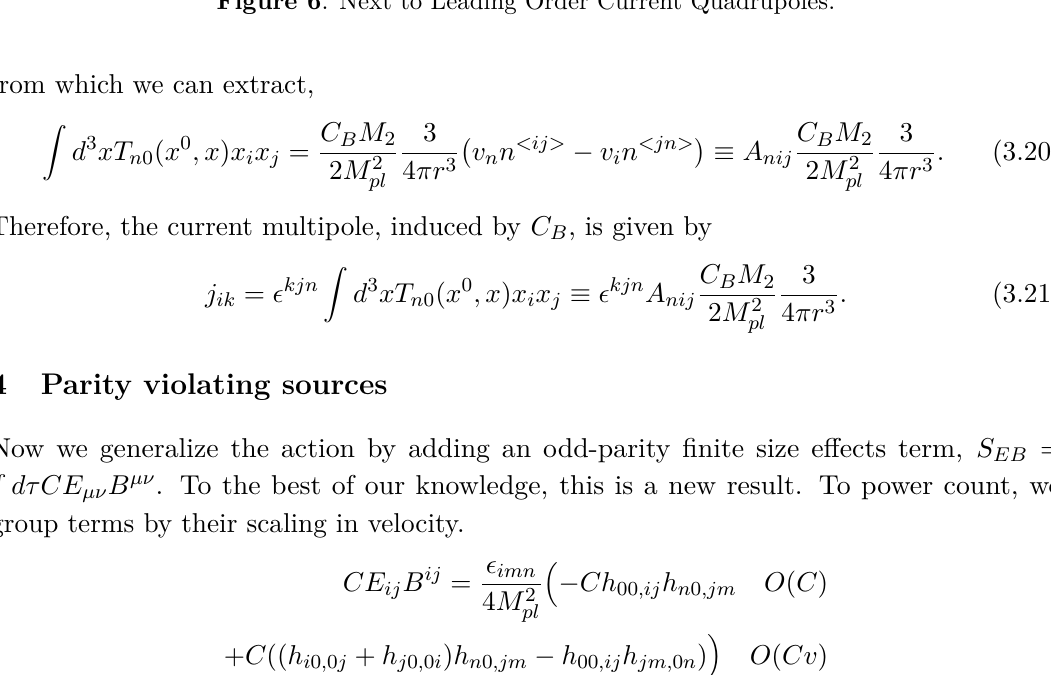
Figure 6 . Next to Leading Order Current